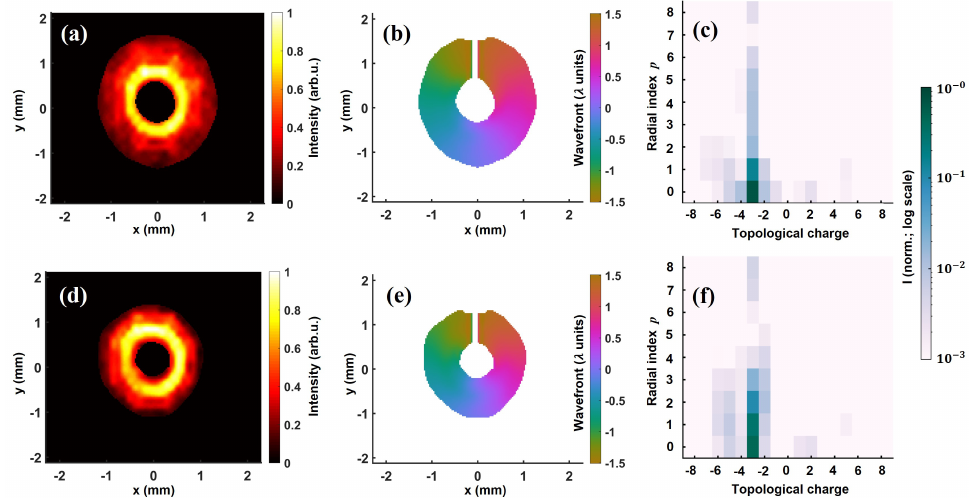
Figure 7. Effect of radial clipping on the modal content of (cid:96) = − 3 vortex beam. ( a ) Intensity, ( b ) reconstructed wavefront in the unit of wavelength, and ( c ) modal content for unclipped beam. In ( d – f ), corresponding intensity, wavefront, and modal composition are shown for ∼ 16 mm iris diameter. The PtV wavefront signifying the topological charge is ∼ 3 λ in both cases. The OAM purity, i.e., contribution to (cid:96) = − 3 mode is ∼ 91%, ∼ 89% for fully open and 16 mm iris diameter, respectively. The contribution to LG − 3,0 mode plunges from ∼ 69% to ∼ 45% for the latter